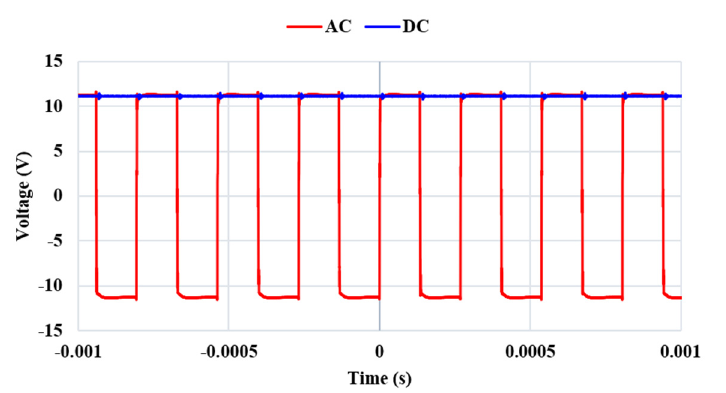
Figure 15. Output V AC and input V DC of full-bridge GaN inverter with snubber circuits; Excel spreadsheet is extracted from Analog Discovery.